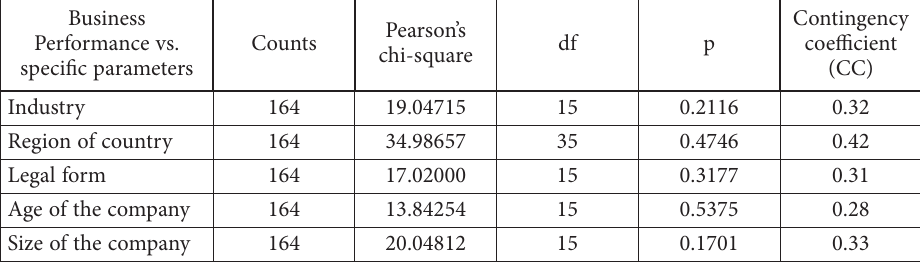
Table 2. Contingency: specific parameters vs. business performance – statistics (source: own) Business Performance vs.